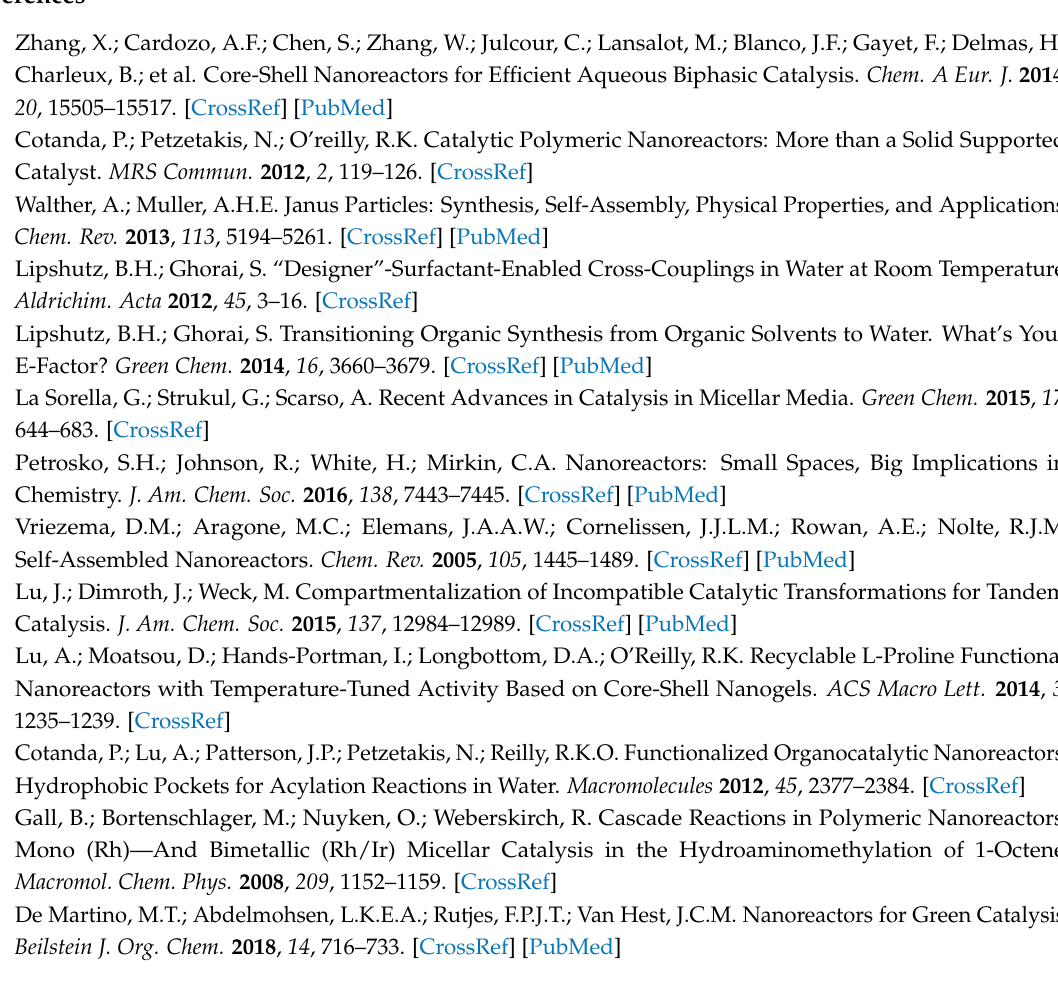
318/s1, Figure S1: Representative Kinetic Data Analysis, Figure S2: PFG-NMR with STD, Figure S3: Langmuir-Hinshelwood Model Fitting, Figure S4: Confirmation of Nanoreactor Activity, Figure S5: Nanoreactor Stability, Figure S6: Nanoreactor Size Tuning with Block Copolymer Concentration, Figure S7: Effect of Sodium Borohydride Equilibration on Induction Time, Figure S8: External and Internal Mass Transfer, Table S1: Langmuir-Hinshelwood Fitting Parameters, Table S2: Rate Constant After